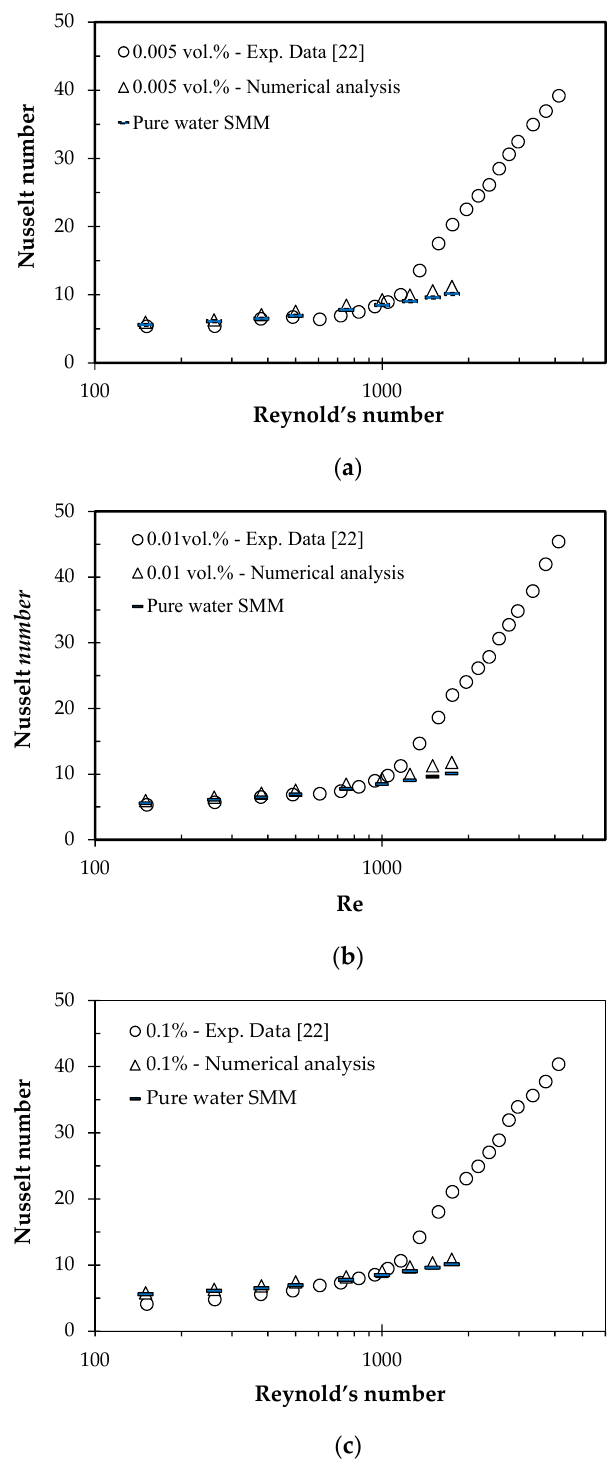
Figure 6. Comparison of the Nusselt number versus the Reynold’s number between the numerical result and the experimental data from the previous study. ( a ) Nanoparticle concentration of 0.005 vol.%. ( b ) Nanoparticle concentration of 0.01 vol.%. ( c ) Nanoparticle concentration of 0.1 vol.%.